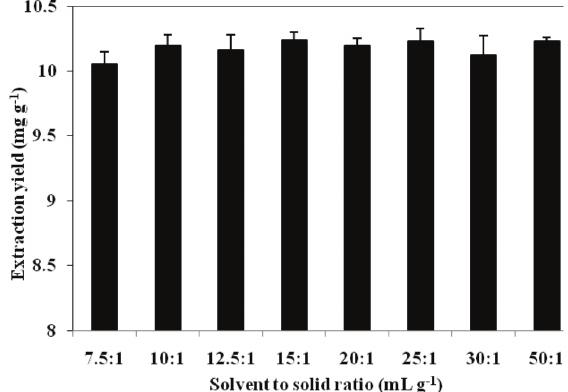
Fig. 3 – Effect of solvent to solid ratio on the extraction yield of Ginkgo flavonoids. ChCl/LA1 containing 40 % (w/w) water was used as extraction solvent at different solvent to solid ra- tios with stirring at 50 °C and 150 rpm for 10